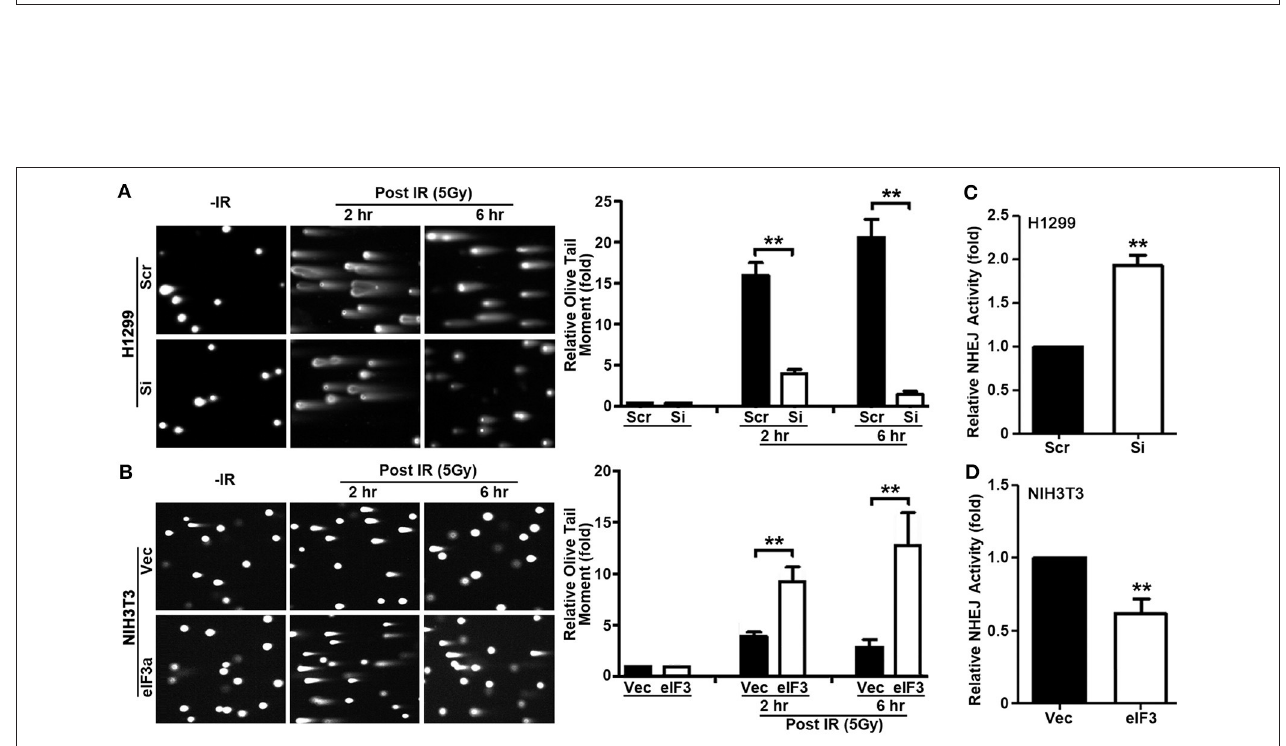
FIGURE 3 | Role of eukaryotic initiation factor (eIF)3a in non-homologous end joining (NHEJ) repair of ionizing radiation (IR)-induced double-strand breaks (DSBs). (A,B) Comet assay was used to determine eIF3a effects on the level of DSBs induced by IR in H1299 cells with transient eIF3a knockdown (A) and NIH3T3 cells with stable eIF3a overexpression (B) compared with their respective control cells. The histograms show the summary of quantitative analysis of Olive tail moment in these cells. (C,D) Host cell reactivation assays using reporter constructs were performed using H1299 cells with eIF3a knockdown (C) and NIH3T3 cells with eIF3a stable overexpression (D) compared with their respective control cells ( n = 3; ** P < 0.01).